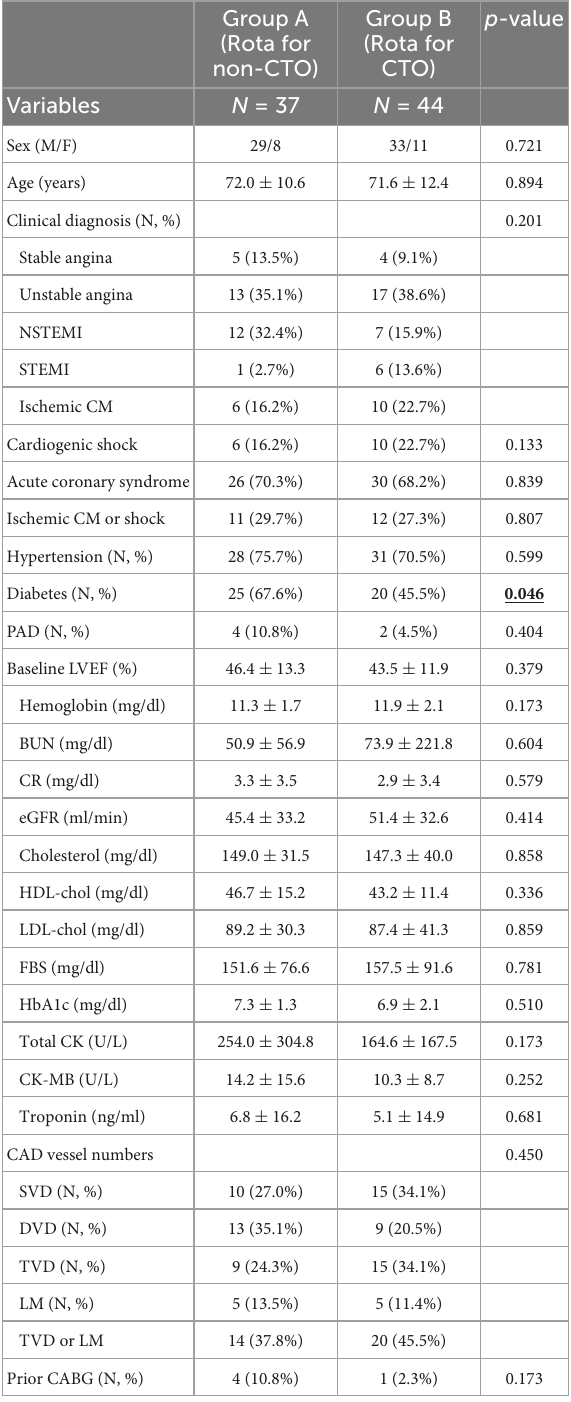
TABLE 1 Demographic data and CAD vessel numbers in patients treated with rotablation for CTO and non-CTO lesions.